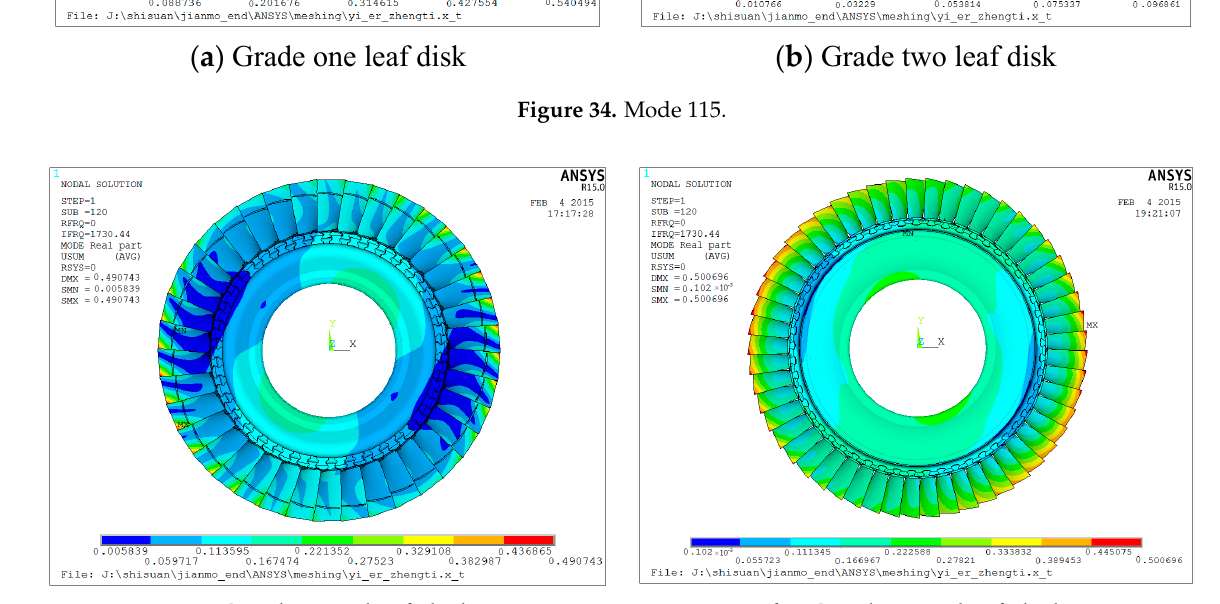
Figure 35. Mode 116.